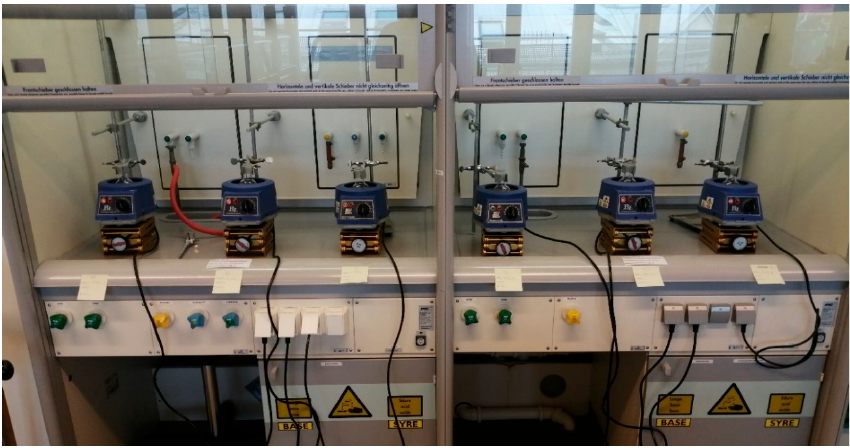
Figure 3. Six samples being simultaneously tested in the vacuum fume hood.